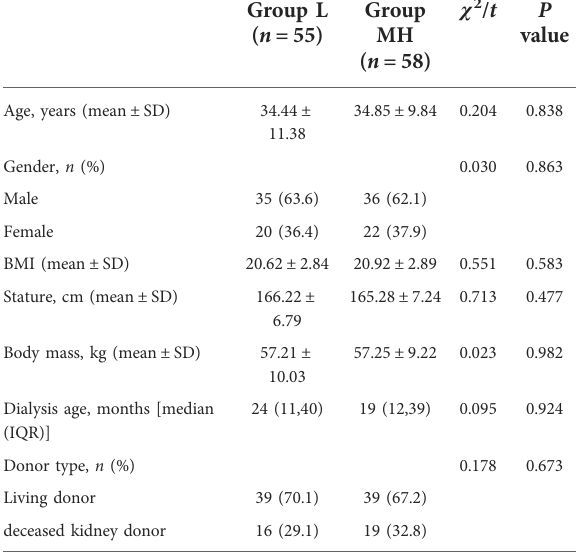
TABLE 1 Descriptive characteristics of KTRs ( n